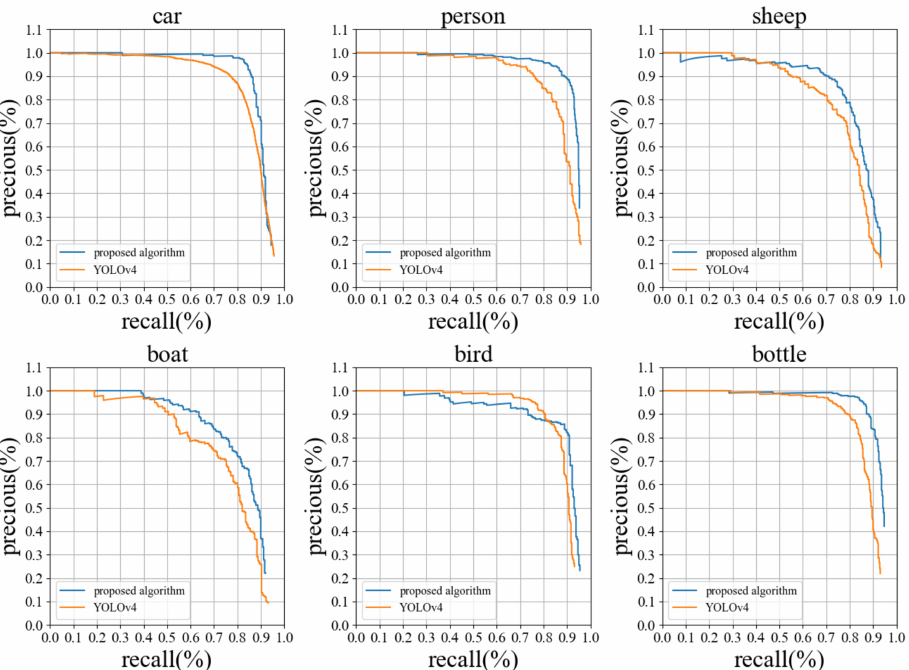
Figure 11. The visualization of P-R curves. The blue curve represents the proposed algorithm and the orange curve represents YOLOv4.